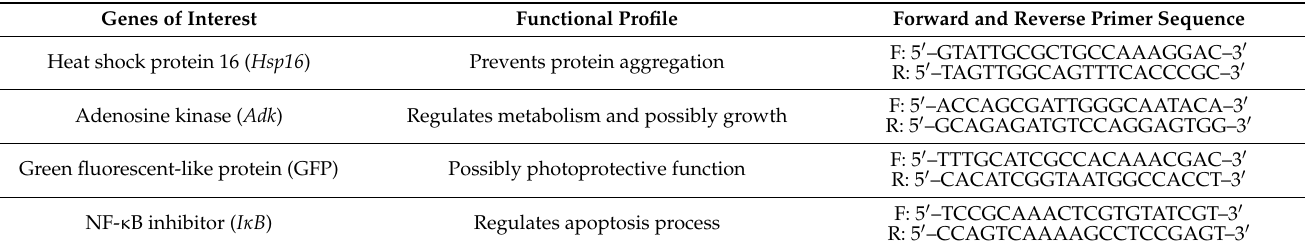
Table 1. List of stress-associated genes of interest and primer sequences used for expression level analyses. Genes of Interest Functional Profile Heat shock protein 16 ( Hsp16